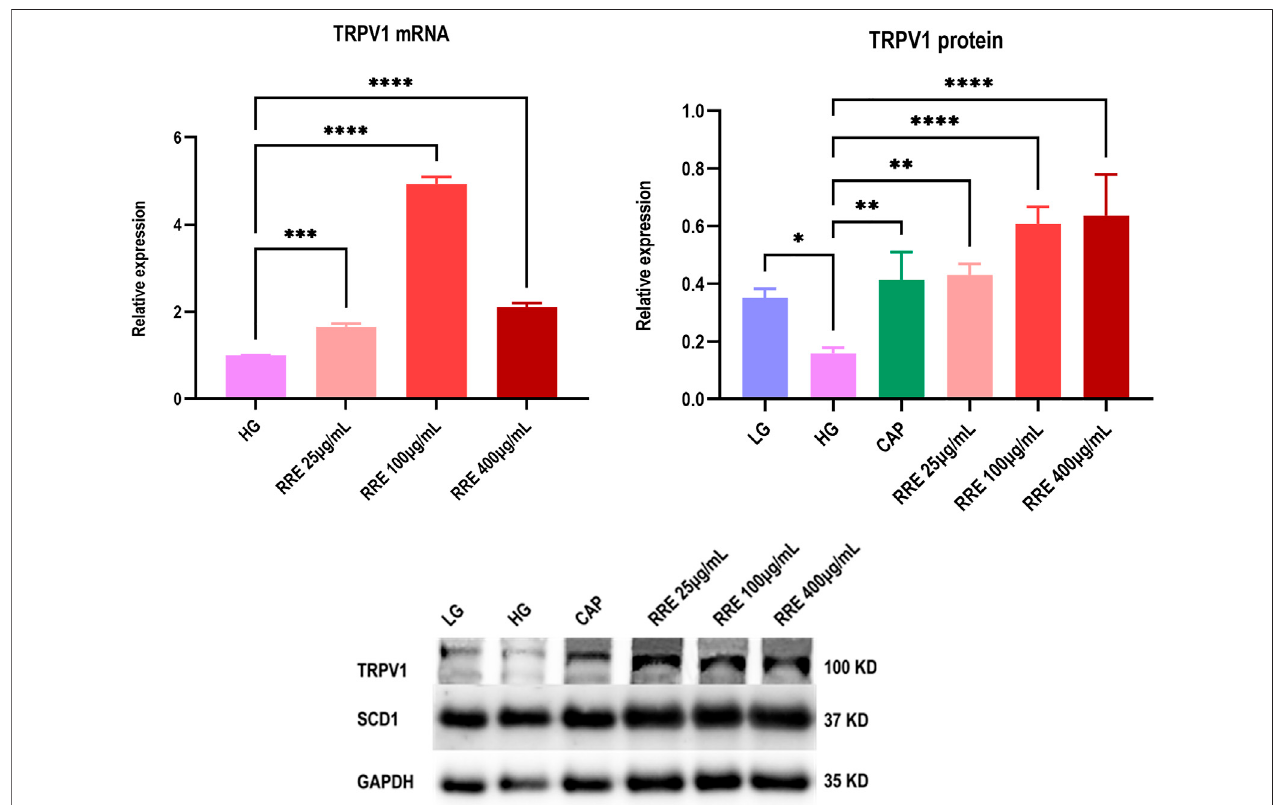
FIGURE 7 | Effect of RRE on mRNA and protein expressions of TRPV1 in HK2 cells: CAP, capsaicin; TRPV1, transient receptor potential vanilloid 1; LG, low glucose; HG, high glucose. Comparison with the HG group, *, p ＜ 0.05; **, p ＜ 0.01; ***, p ＜ 0.001; ****, p ＜ 0.0001.